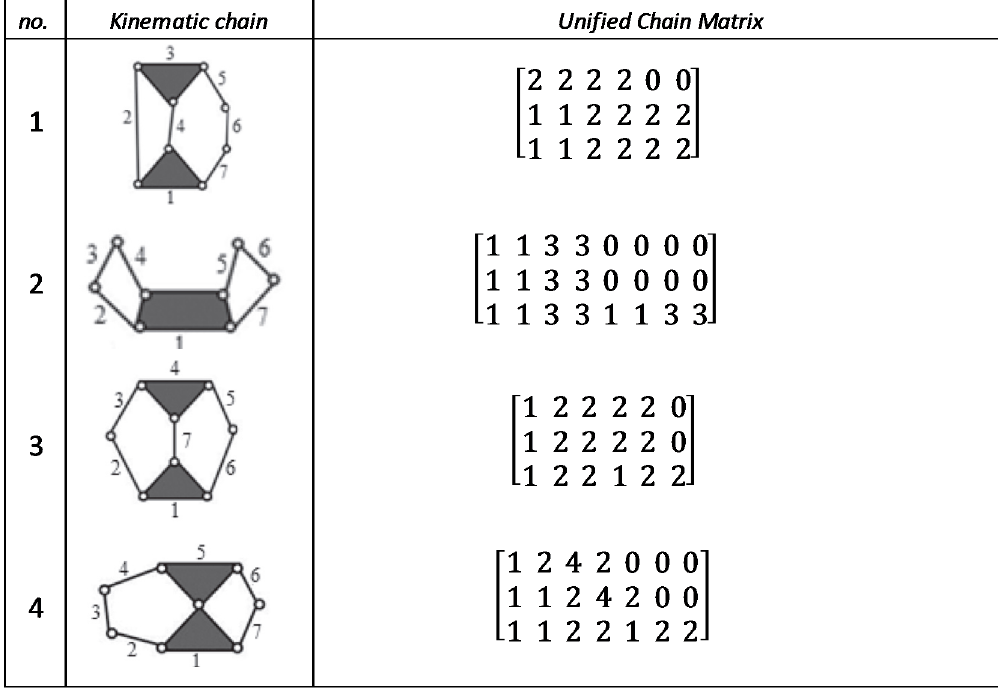
Figure A5. Unified chain matrix, UCM, for all 7 links 2-DOF KCs with simple joints [40].